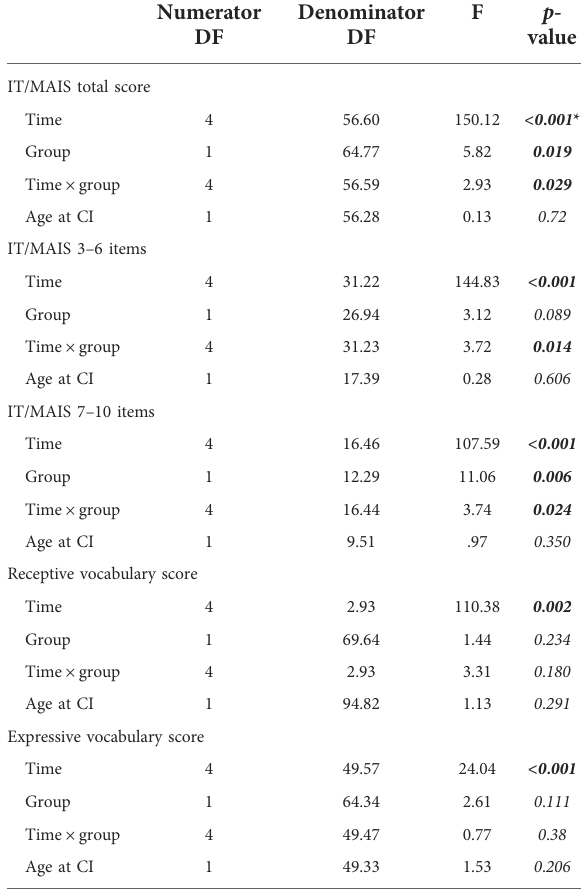
* p -values below 0.05 (bold) indicate signi fi cant